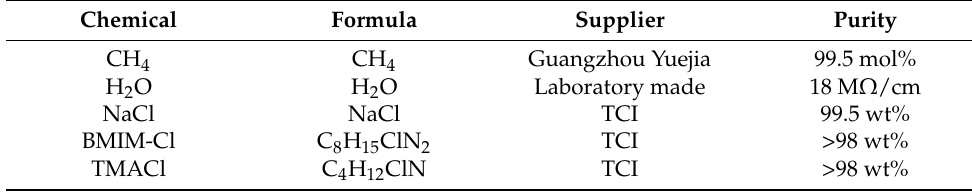
Table 1. The materials used for the experiments.